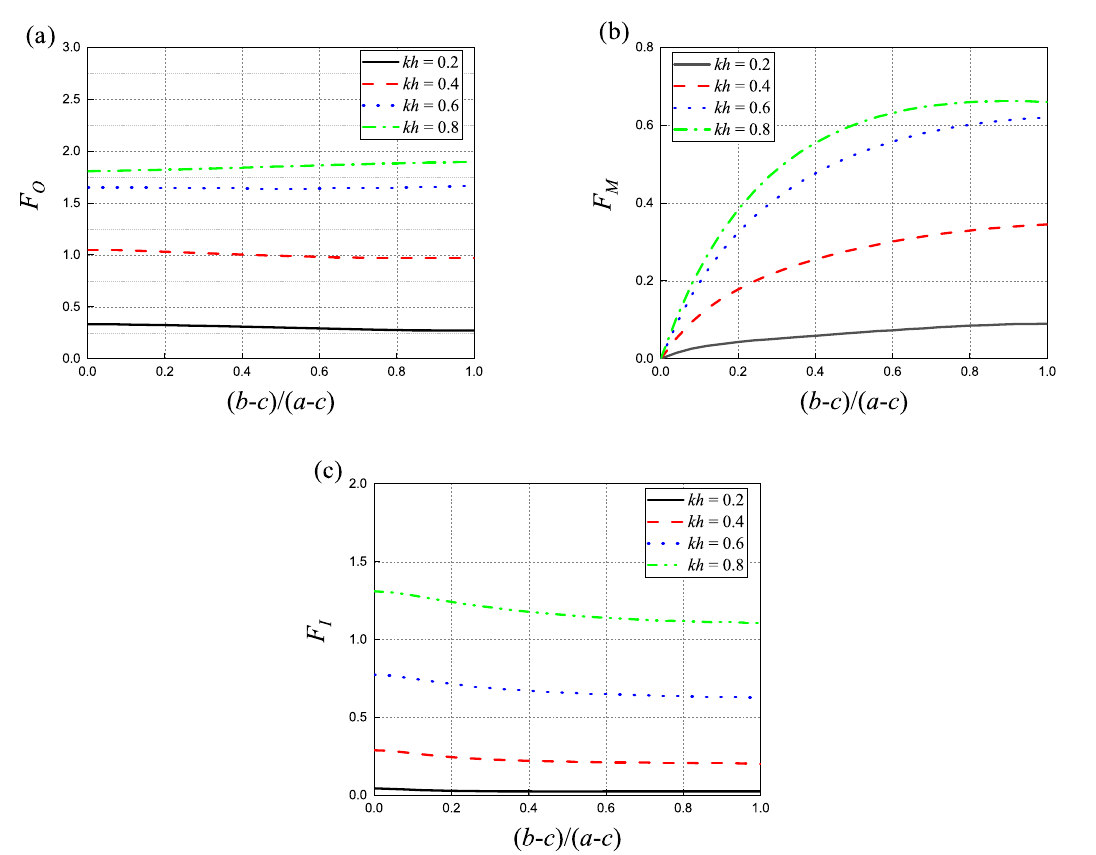
Figure 13. Hydrodynamic forces on the outer, middle and inner cylinders versus ( b − c ) / ( a − c ) for different values of kh with e / a = 1.0, β = 0, h / a = 1 and c / a = 0.5 : ( a ) the outer cylinder, ( b ) the middle cylinder, ( c ) the inner cylinder.